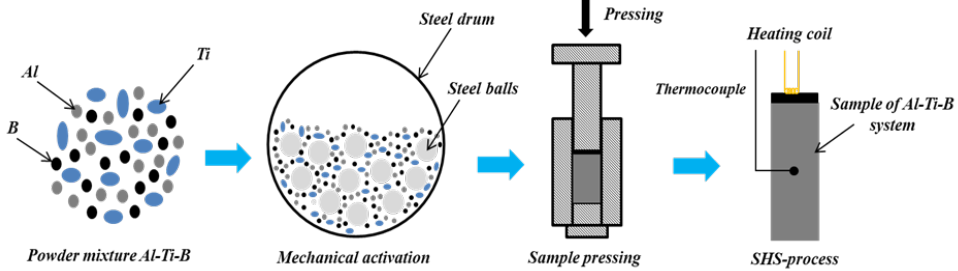
Figure 1. Representation of the Al-Ti-B powder mixture sample preparation process.